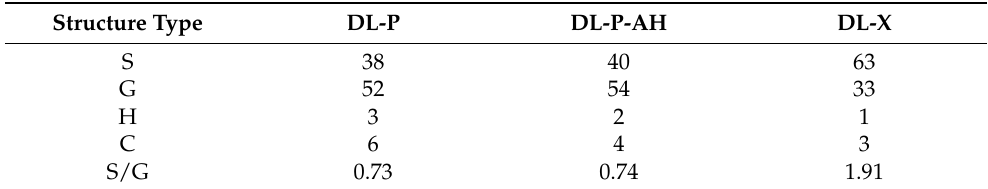
Table 3. Relative molar abundance (%) of the structural units of different types and S/G ratio for the birch phloem and xylem dioxane lignin preparations determined by Py-GC/MS. Structure